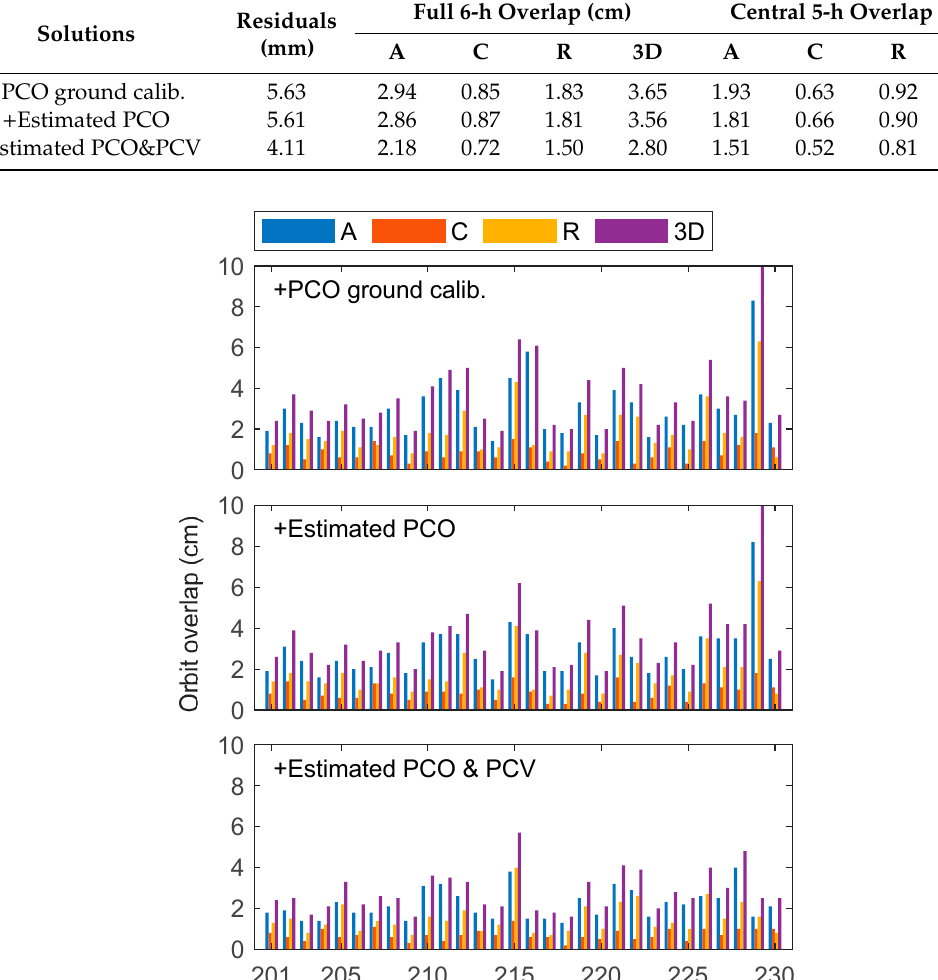
Table 3. Phase residuals and orbit overlap differences of GPS-only solutions in the along-track, cross-track, radial direction and 3D.